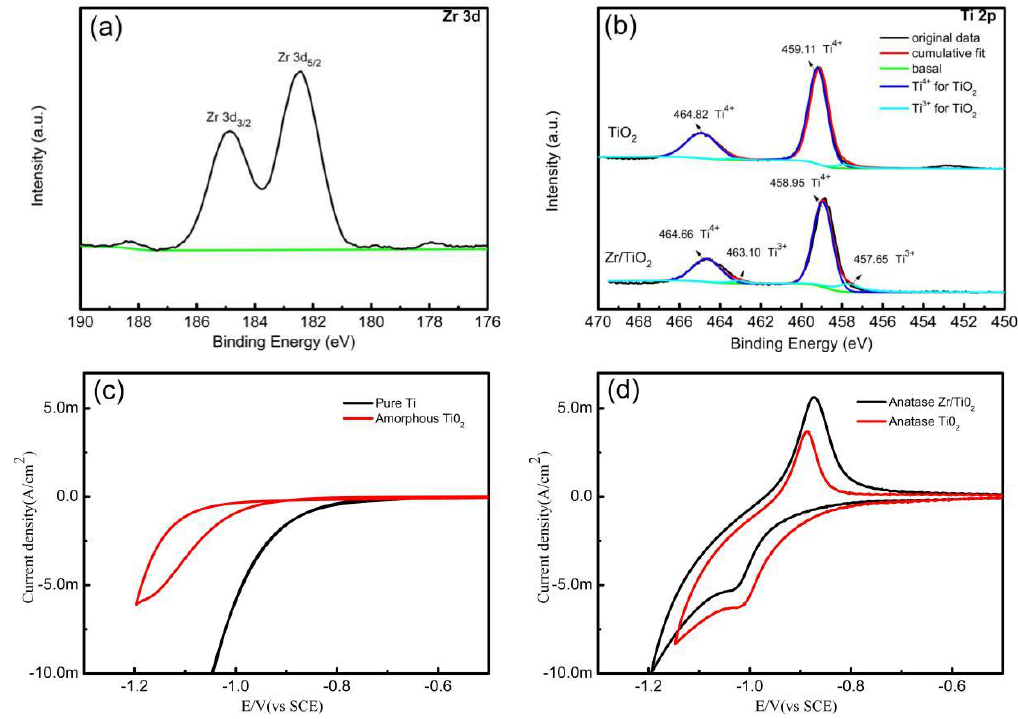
Figure 3. XPS spectra of undoped and Zr 4+ doped TiO 2 nanotube array surface: ( a ) Zr 3d, ( b ) Ti 2p; CVs of different electrodes in 2 mol·L −1 HCl solution (scanning rate: 20 mV·s −1 ): ( c ) pure titanium and amorphous TiO 2 nanotube array electrode; ( d ) undoped and Zr 4+ doped anatase TiO 2 nanotube array electrode.